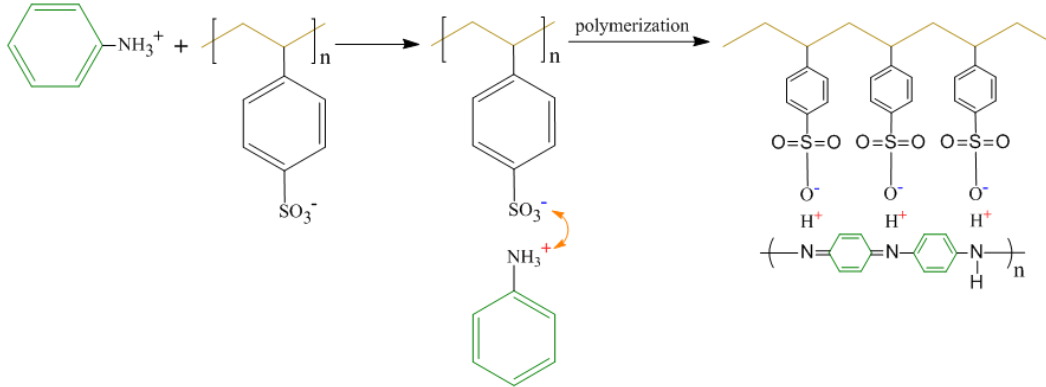
Scheme 1: Synthesis reactions leading to PSSA-PANI